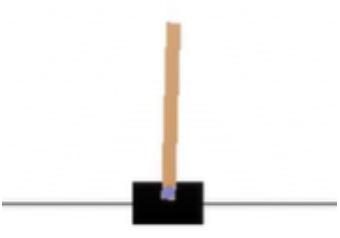
Figure 10. Rendering of the Cartpole